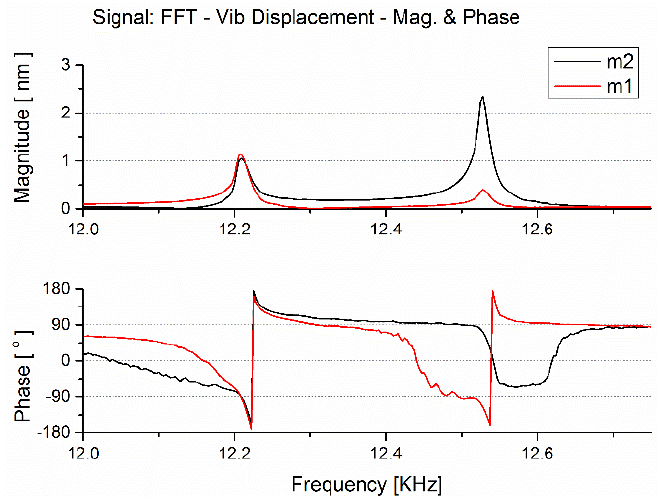
Figure 7. The tested sense mode frequency response of the fabricated MEMS